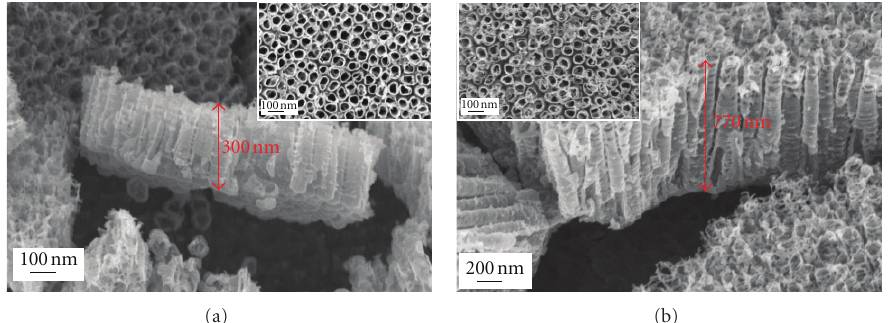
Figure 5: FESEM cross-sectional view images of (a) TNT and (b) TNT/EDTA; the insets show the top view images of the corresponding samples.